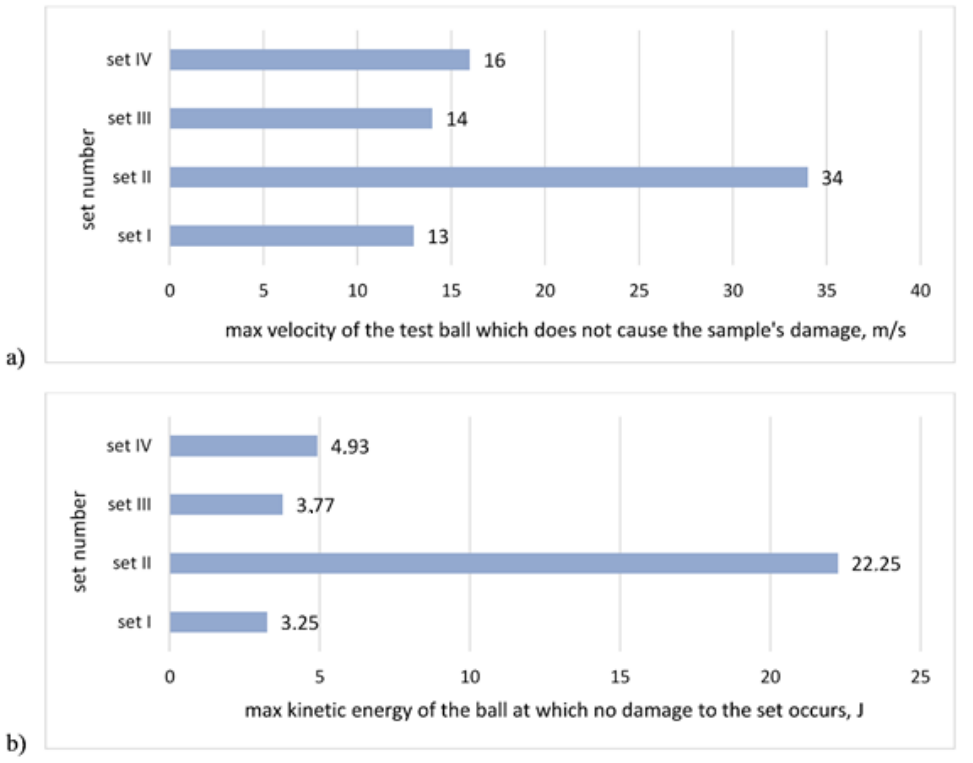
Figure 4. Results of hail resistance tests for sets with different adhesives and the same mesh: ( a ) in reference to the maximum velocity of the test ball, which does not cause the sample’s damage, ( b ) calculated as the maximum kinetic energy of the test ball, which does not cause the sample damage.